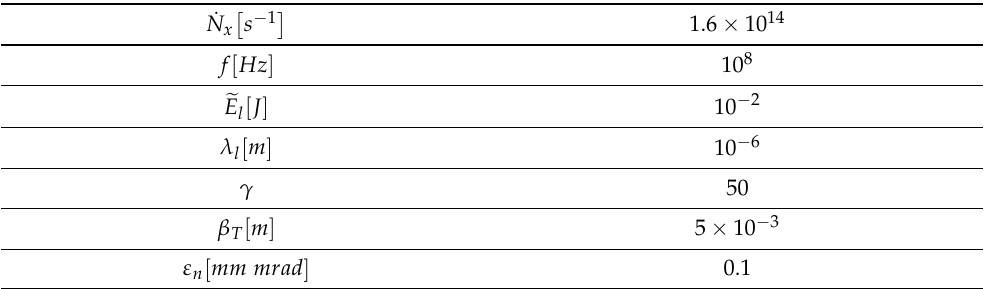
Table 1. Reference Parameters for CBS X-ray